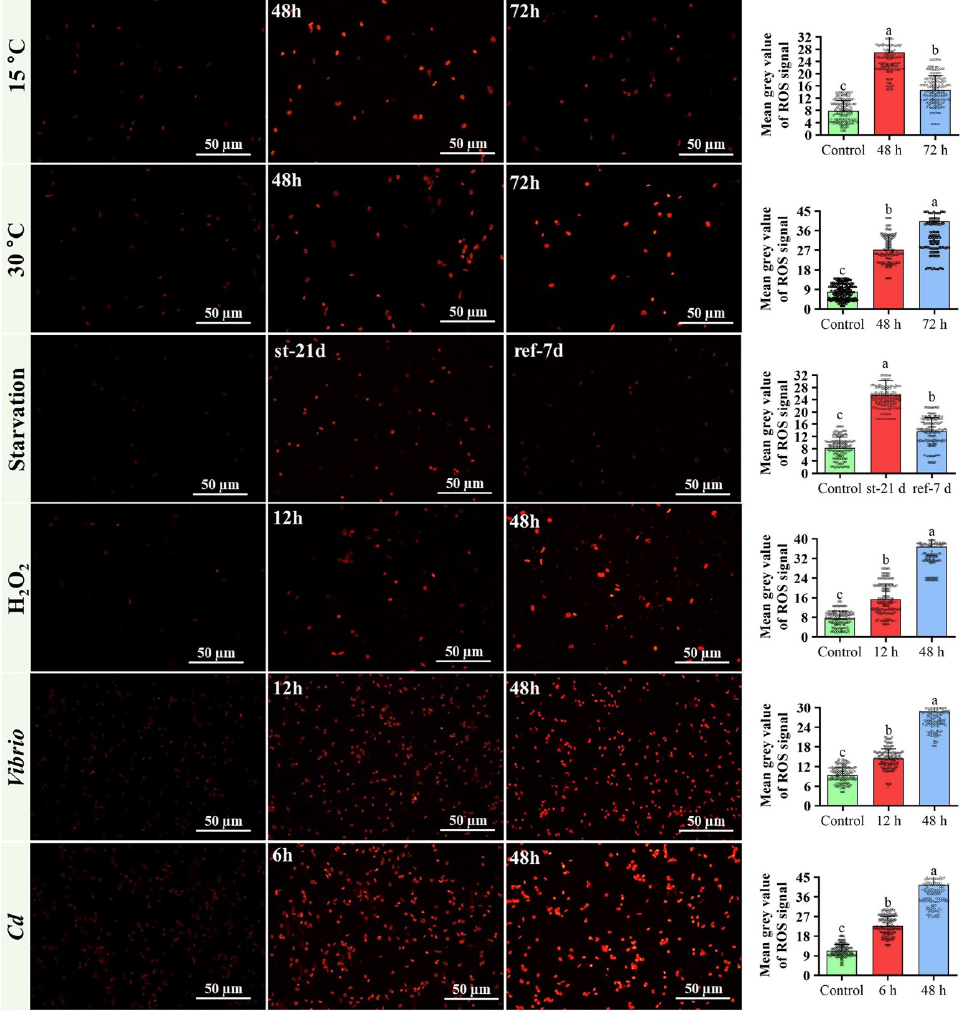
Figure 10. Detection of reactive oxygen species (ROS) in thermal-stressed, starved, H 2 O 2 -induced, bacterial-challenged, and Cd-exposed Pacific abalone. ( A ) Fluorescent images of dihydroethidium (DHE) stained digestive gland tissue samples. ( B ) Level of ROS production was analyzed by measuring mean grey values of DHE signal. Significantly different levels ( p < 0.05) are denoted by different